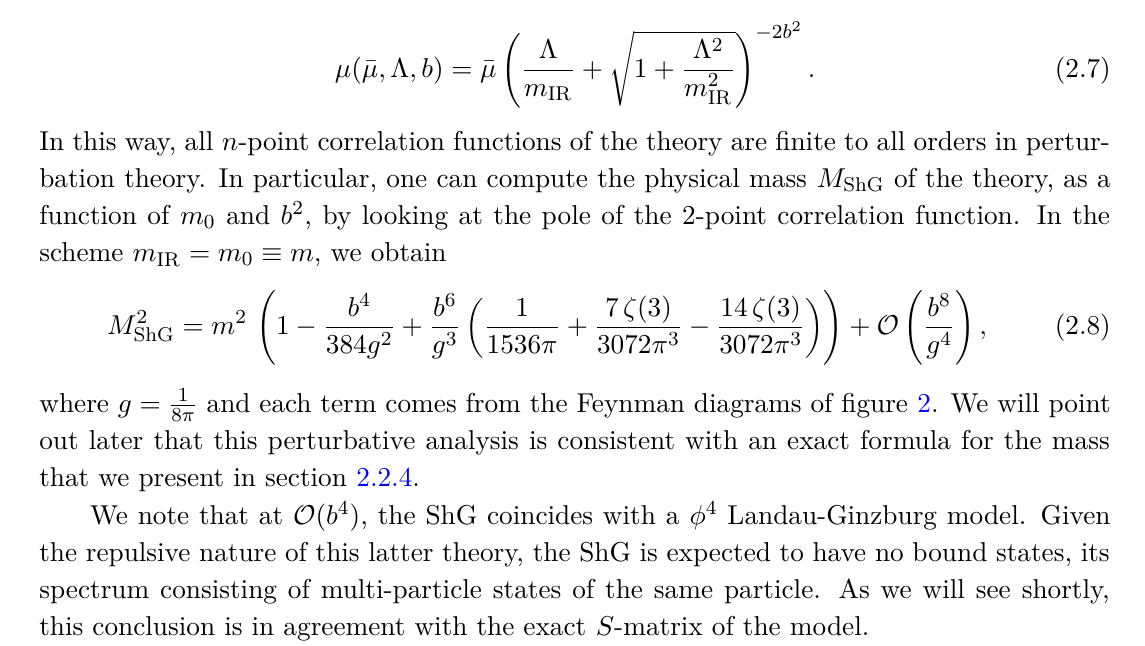
Figure 2. Feynman diagrams up to order b 6 entering the expansion of M 2 distinguished by a blue